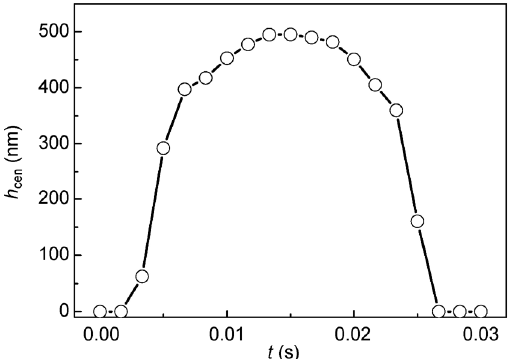
Fig. 14 Variations of central film thickness with time, PAO100, u e = 95.1 mm/s, w = 30 N, D ini = 274 μ m.